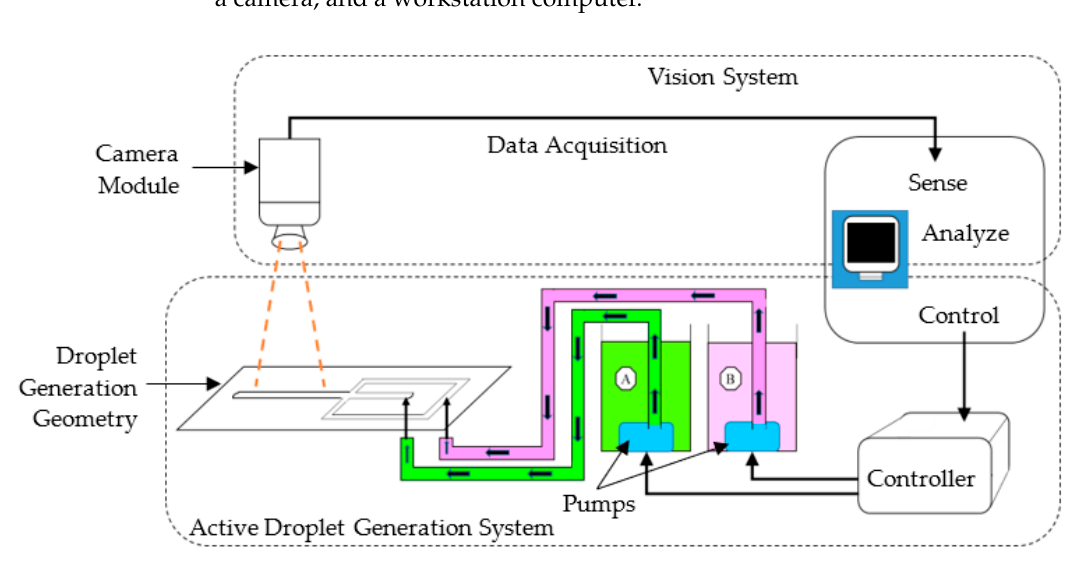
Figure 2. Proposed